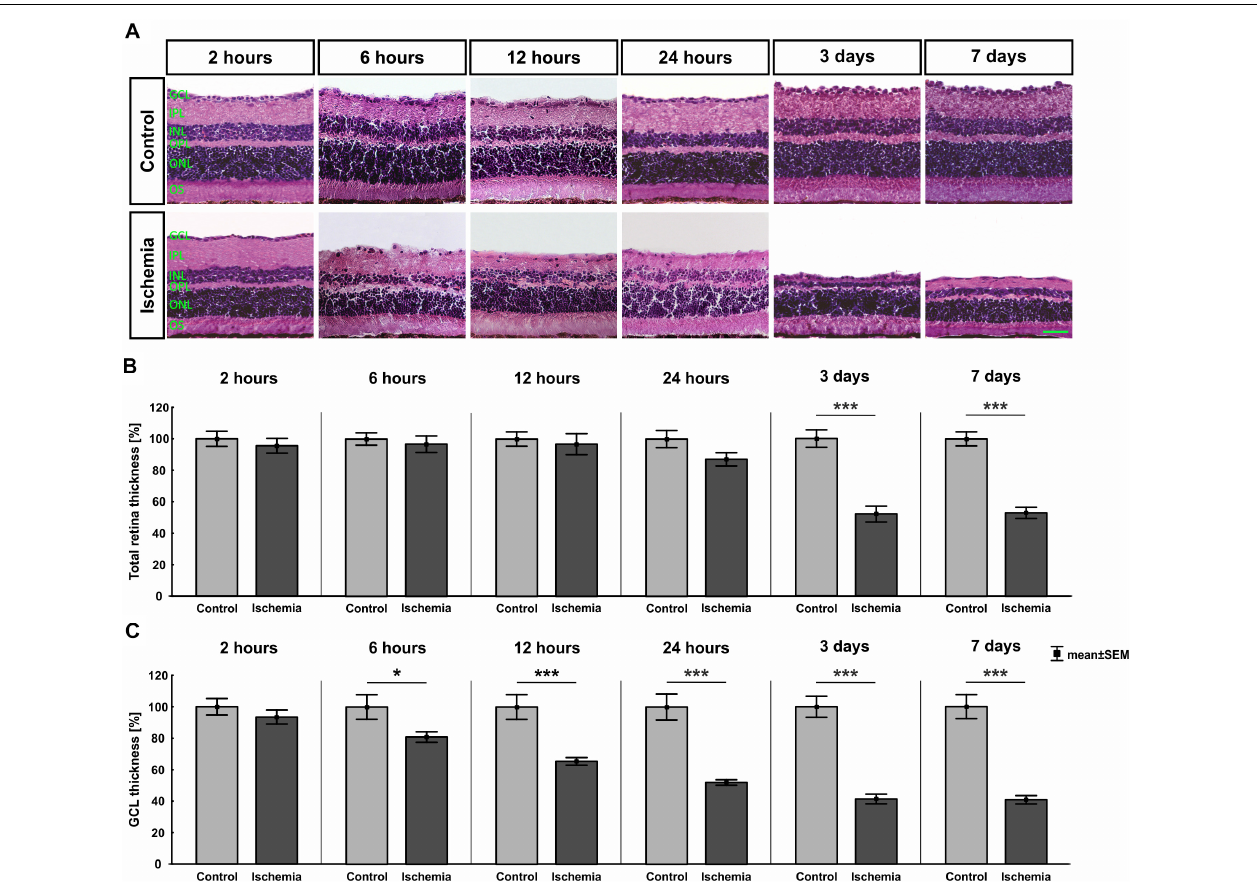
FIGURE 2 | (A) Retinal cross-sections of all points in time were stained with H&E ( n = 7–8/group). A decline of the total retinal thickness was observed in the ischemia group over time. (B) A significant decrease of the whole retinal thickness was measured in ischemic eyes starting at day 3 after I/R (3 days, 7 days: p < 0.001). (C) The GCL seems to be most sensitive against an ischemic insult. The thickness of this layer was significantly reduced already at 6 h ( p = 0.036). This degeneration progressed over time (12 h: p = 0.0009; 24 h, 3 days, 7 days: p < 0.001). ∗ p < 0.05, ∗∗∗ p < 0.001. GCL, ganglion cell layer; IPL, inner plexiform layer; INL, inner nuclear layer; OPL, outer plexiform layer; ONL, outer nuclear layer; OS, outer segment. Scale bar: 20 µ m.